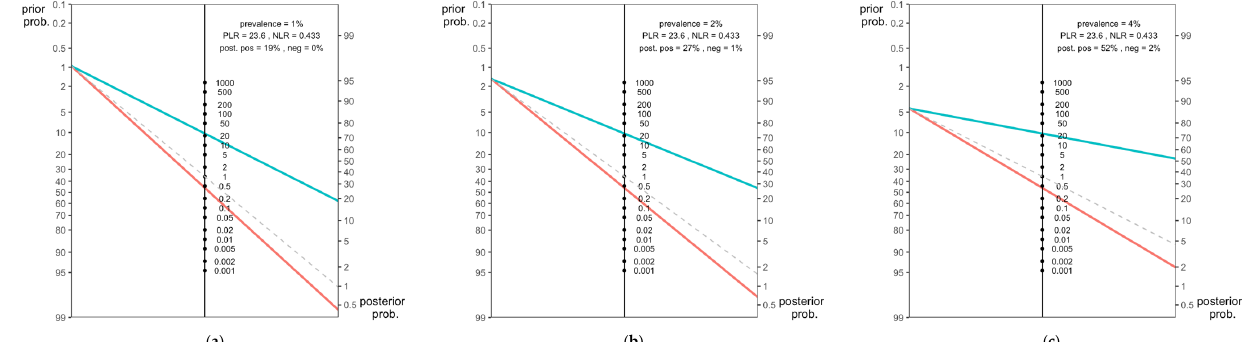
Figure 5. Fagan’s nomograms for SARS -CoV-2 Real-Time Quantitative Polymerase Chain Reaction (RT-qPCR) were performed on specimens of exhaled breath condensate. In the model, actual prevalence estimates for SARS-CoV-2 in Italy were included from 3 different time periods: (a) 31/12/2020 (1%), (b) 31/12/2021 (2%), and (c) 31/01/2022 (4%). Assuming that RT-qPCR on exhaled breath condensate has an estimated diagnostic sensitivity (Se) of 69.5% and specificity (Sp) of 98.3%, with corresponding estimates for PLR and NLR respectively of 23.608 and 0.433, the post-test probability that a positive case is truly infected by SARS-CoV-2 would be approximately 19% (blue line) for 1% prevalence, 27% for 2%, and 52% for 4% prevalence. Alternatively, if the patient tests negative, the post-test probability that he/she is truly infected by SARS-CoV-2 would be approxi- mately 0% (red line) for 1% prevalence, 1% for 2% prevalence, 2% for 4% prevalence. ( a )31 December 2020. ( b )31 December 2021. ( c )31 January 2022.